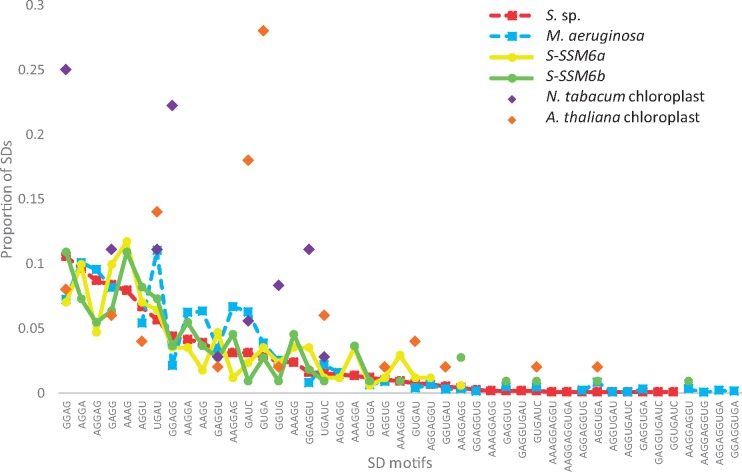
—Comparisons in SD motif usage among Cyanobacteria, cyanophages, and chloroplasts. Usage of SD motifs at optimal DtoStart is comparable among Cyanobacteria S. sp. (red), M. aeruginosa (blue), cyanophage S-SSM6a (yellow), and cyanophage S-SSM6b (green), but varies appreciably in N. tabacum chloroplast (purple) and in A. thaliana chloroplast (orange). All data points presented have nonzero SD proportions.